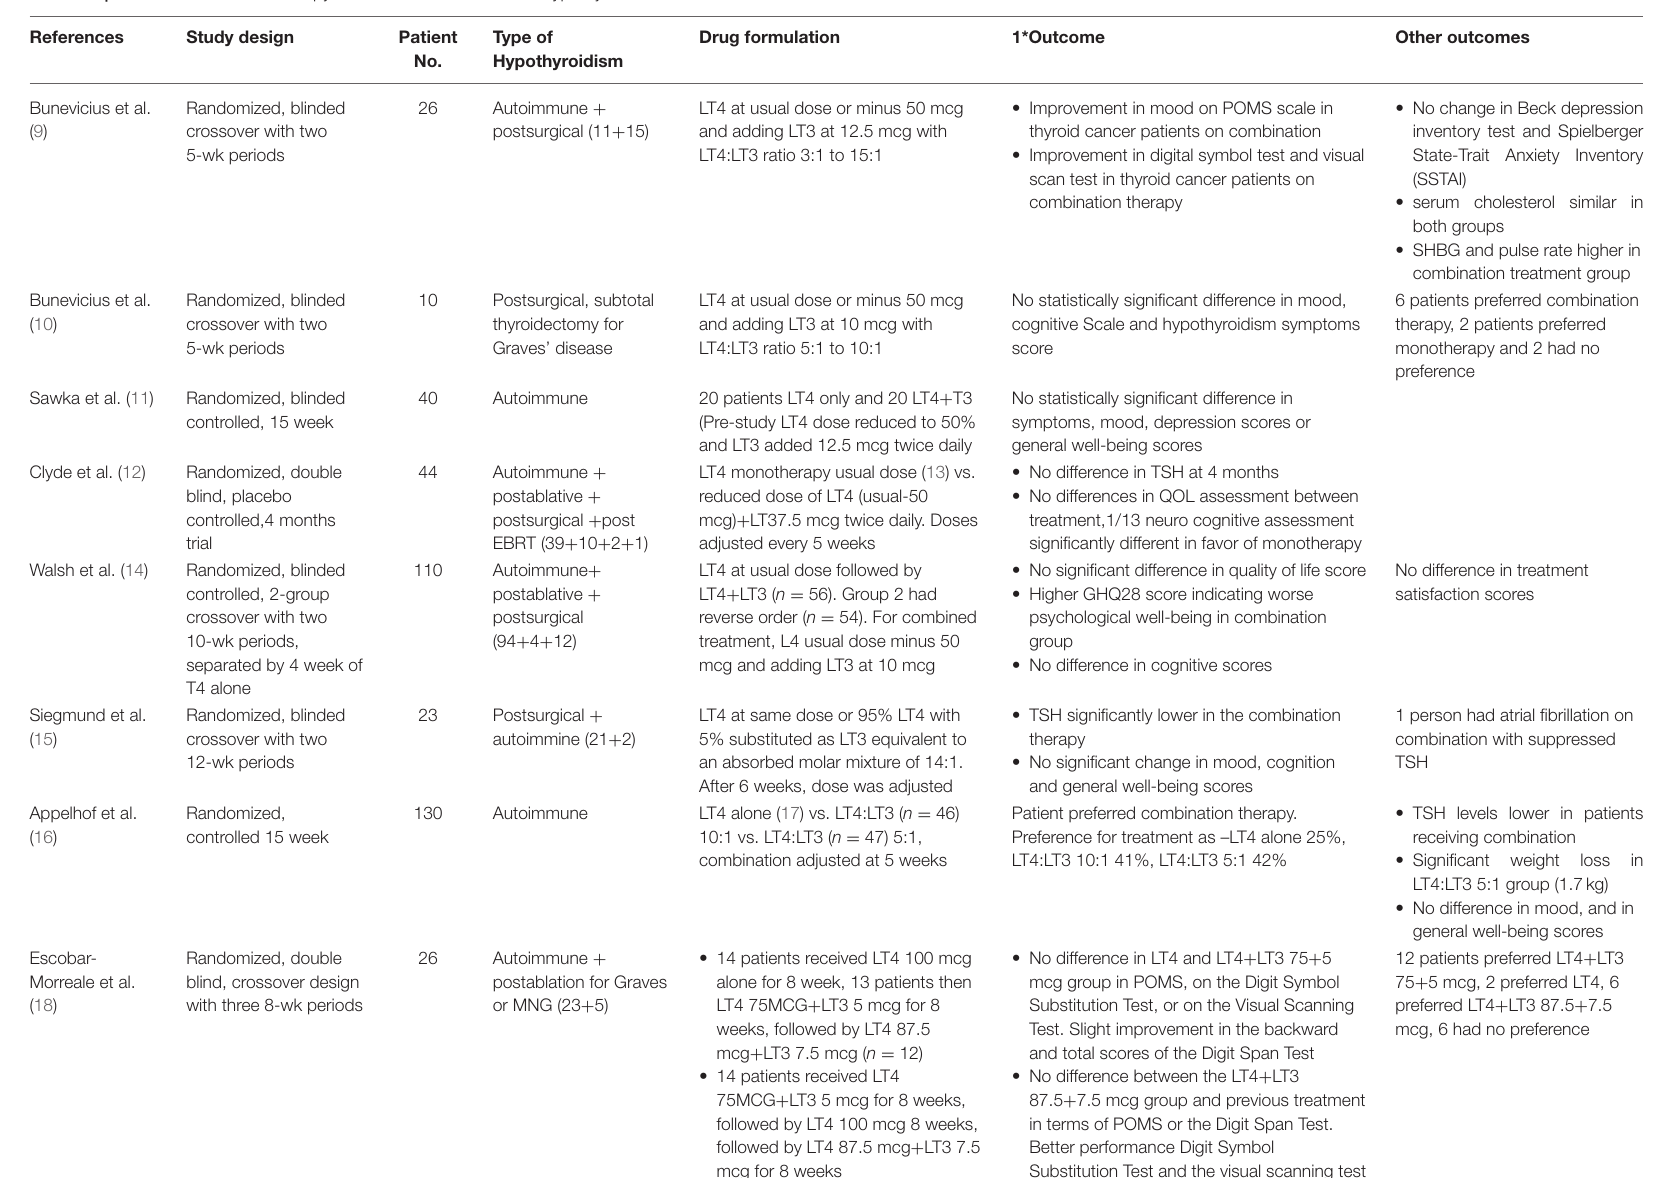
TABLE 1 | LT3:LT4 combination therapy studies for the treatment of